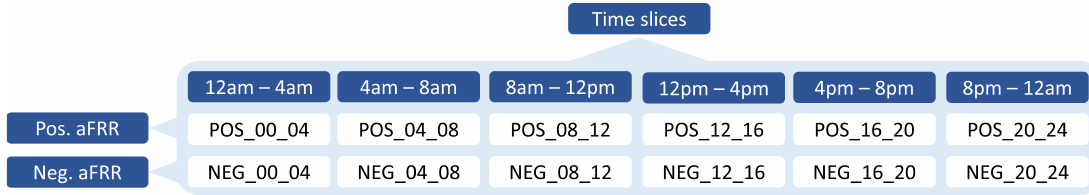
Figure 2. Time slices of products in the considered FRR market design (October 2018–July 2019)